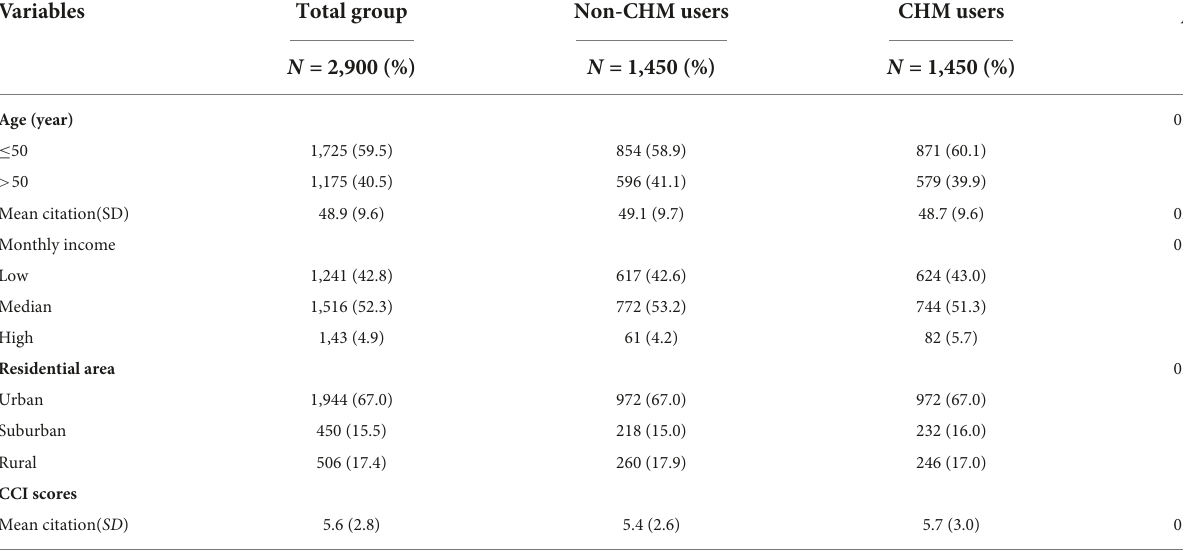
TABLE 1 Demographic data and selected comorbidities of study